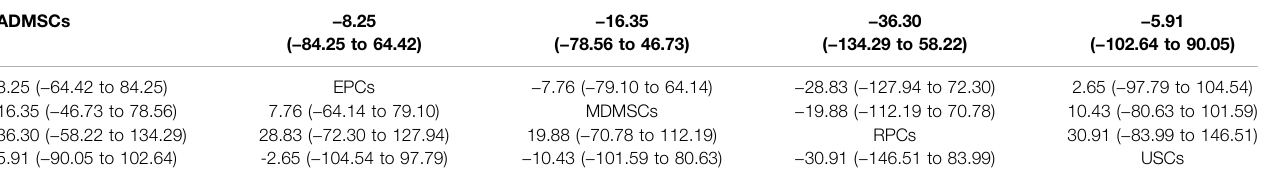
Table 16 ; The comparison-correction funnel plot was basically symmetrical, suggesting that publication bias was less likely ( Figure 10B ); The ranking results showed that proliferation of resident cells in ADMSCs group was the highest ( Figure 10C );